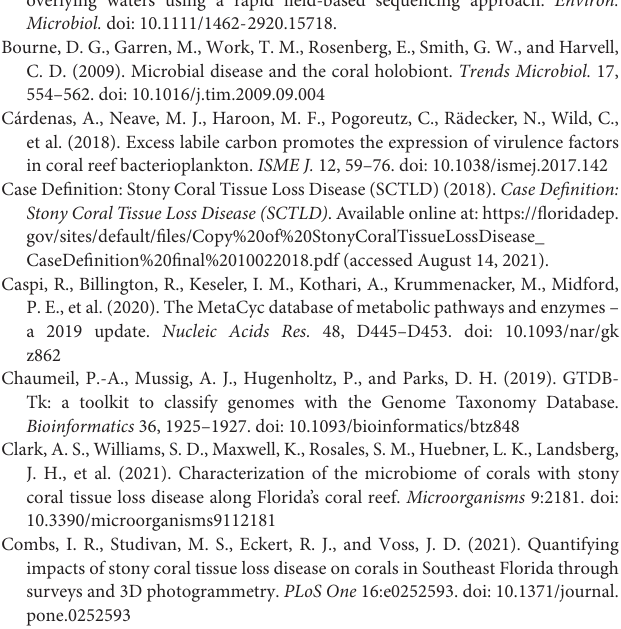
Supplementary Figure 3 | Orthologous gene clusters among metagenome-assembled genomes (MAGs). (A) Upset plot showing the intersections of shared orthologous gene clusters. Each bar represents the number of orthologous gene clusters shared and the dot plot represents the MAGs in which the groups intersect. Highlighted are the shared orthologs within each order: Pseudomonadales (dark purple), Beggiatoales (light purple), Rhodobacterales (dark green), Rhizobiales (light green), Flavobacteriales (gray), and Campylobacterales (salmon). The orthologous gene clusters found in all MAGs are highlighted by the gold dots. (B) Alluvial plot of KEGG pathway counts of orthologous gene clusters that are intersected by bacterial order and among all MAGs (labeled “All”).